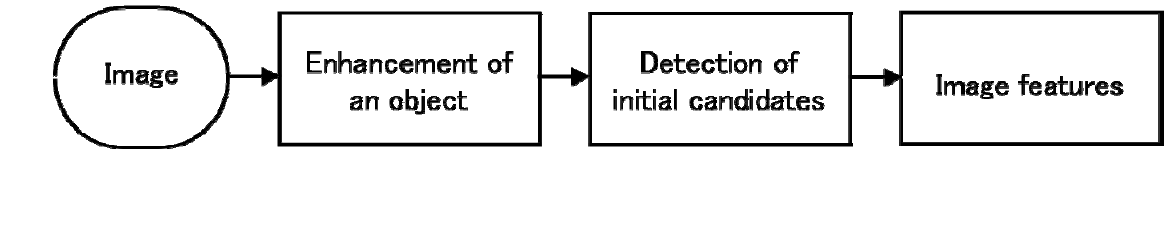
Figure 3. Scheme of feature extraction in a CAD